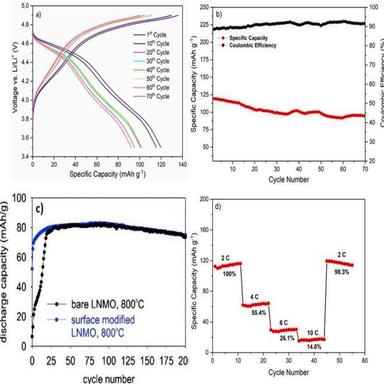
a) Charge-discharge curves, b) cycling performance of LNMO at 2C for 70 cycles, c) cycling performance of commercial LNMO/Li cell at 0.5C, and d) rate capability of LNMO/Li cell at different C-rates. Reproduced from Ref. with permission from the Royal Society of Chemistry.